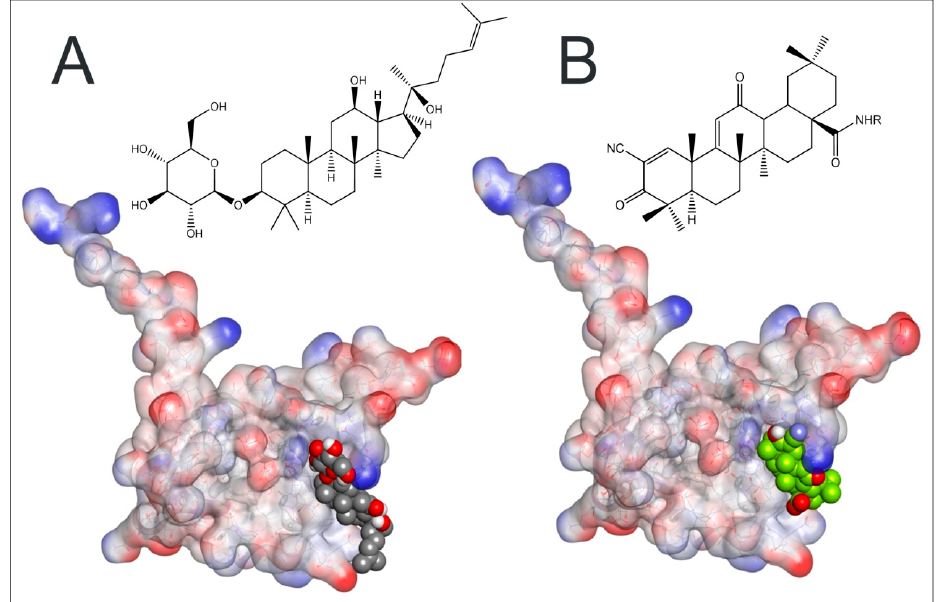
Figure 9. Docking of Rh2 ( A ) in comparison to bardoxolone ( B ) in the crystal structure of Keap1 BTB-domain (4CXT.pdb).